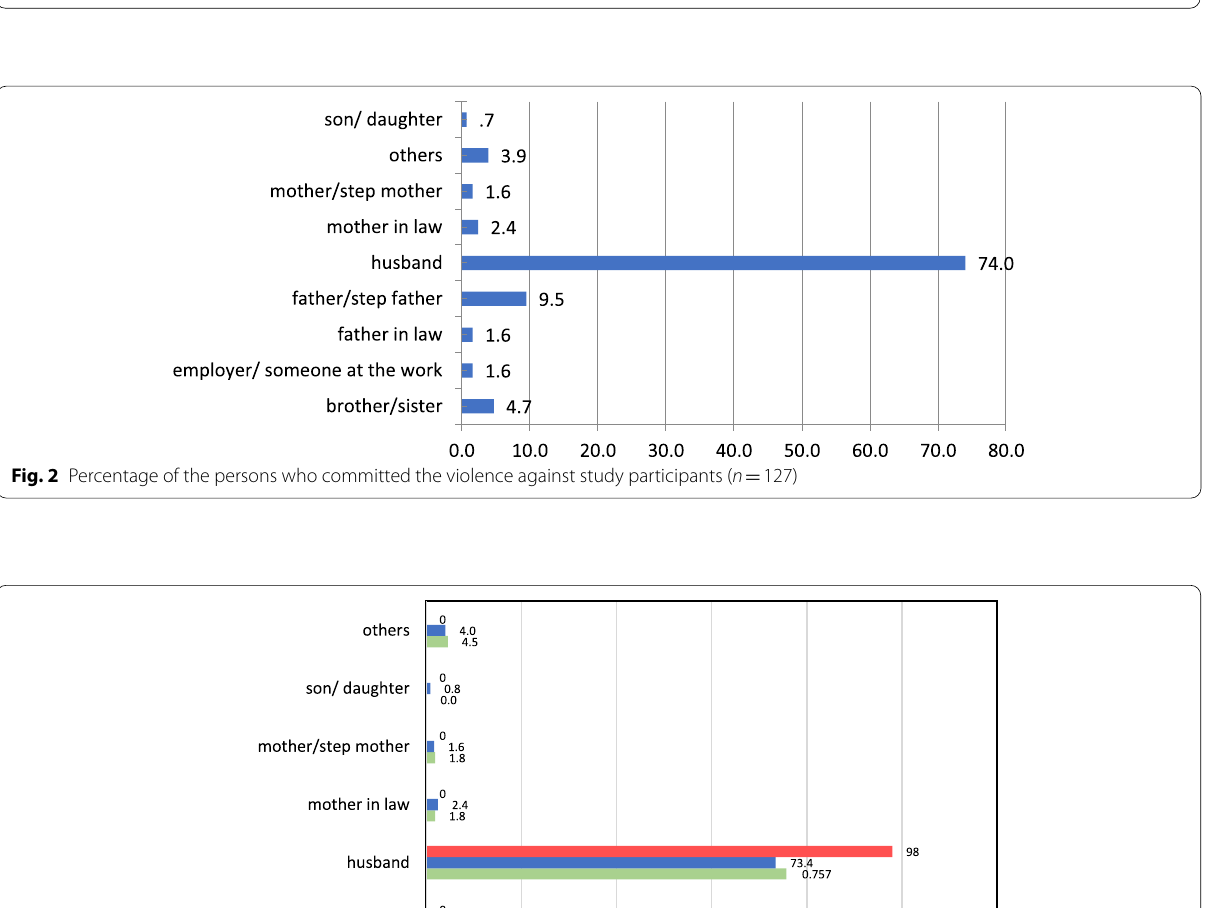
Fig. 1 Prevalence of types of domestic violence among the studied women in eight governorates, Egypt, 2020 ( n